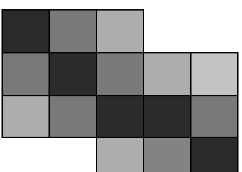
Figure.6 the schematic of mosaic line, the black represent the pixel positions of the mosaic